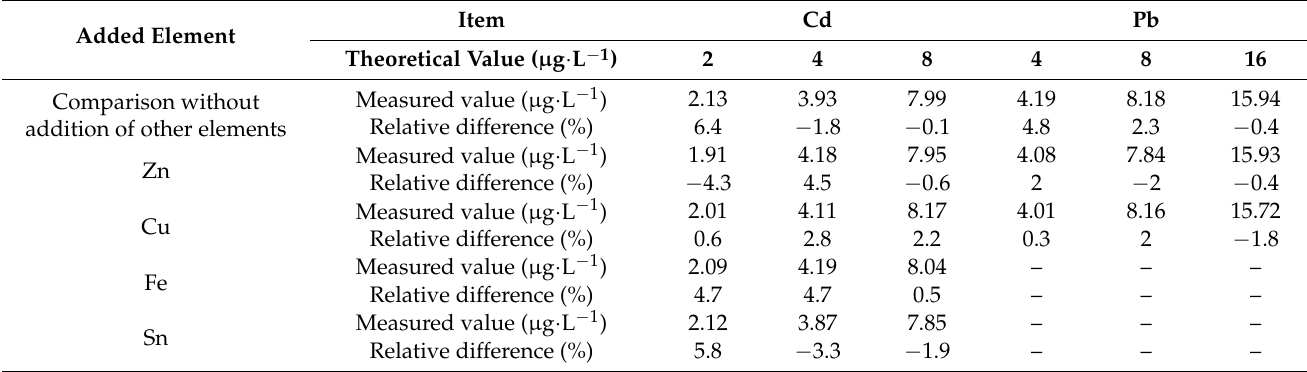
Table 3. Study the influence of inorganic